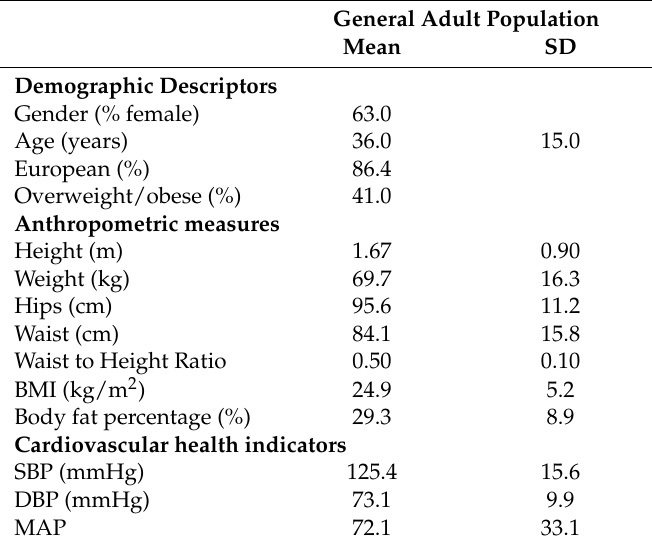
Table 4. General population characteristics 1